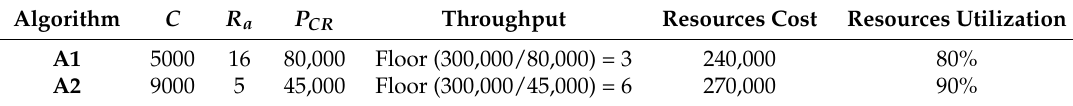
Table 1. The instance in a large device.